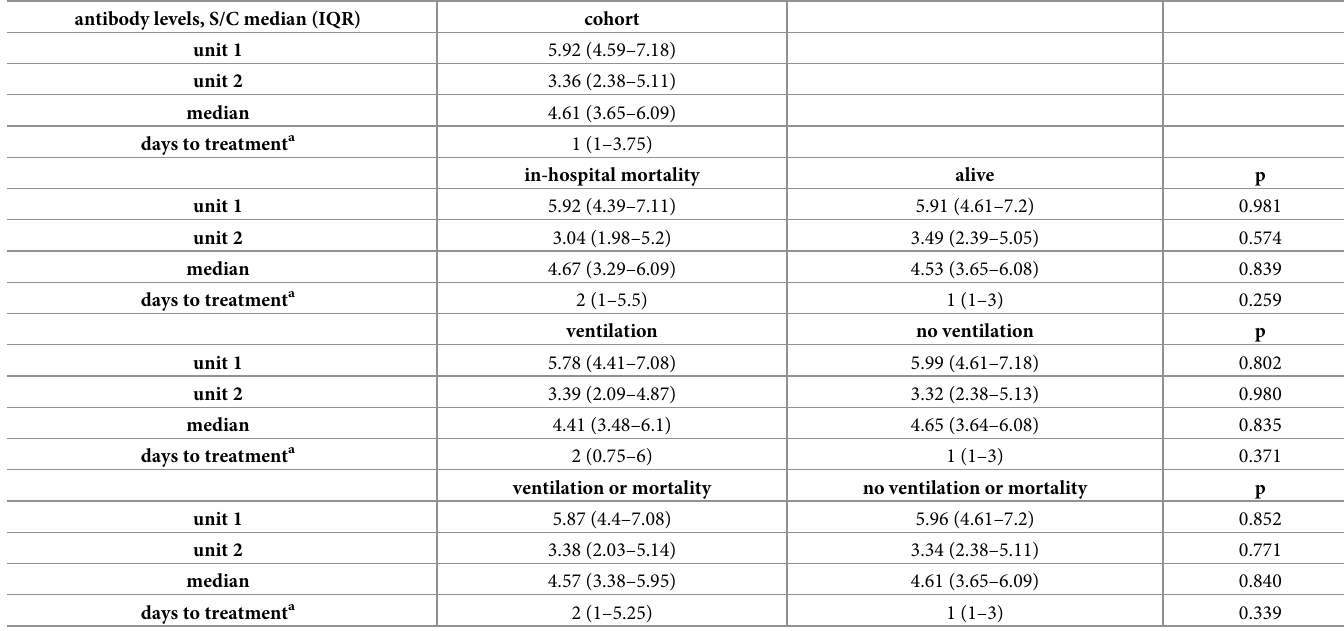
Table 2. Antibody levels, days to treatment and in-hospital mortality, ventilation. antibody levels, S/C median